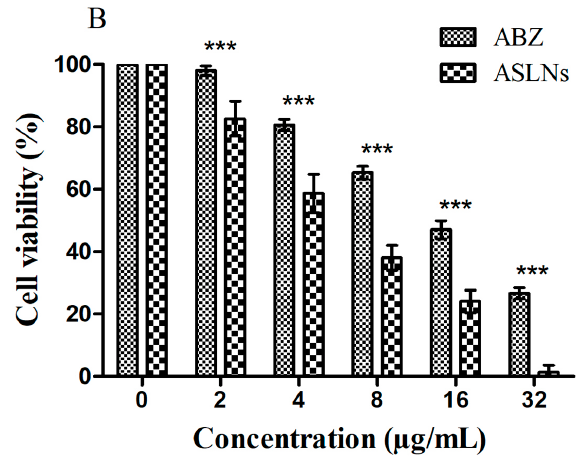
Figure 5. Graph showing the cytotoxic potential of control and BSLNs against U-87 MG cells (mean ± SEM, n = 3). ( A ) Comparison of cytotoxicity of ABZ and ASLNs in U-87 MG cells (mean ± SEM, n = 3). ( B ) Statistical analysis of data was performed using 2-way ANOVA, followed by Bonferroni’s Multiple Comparison Test. *** Denotes significance at p < 0.001.